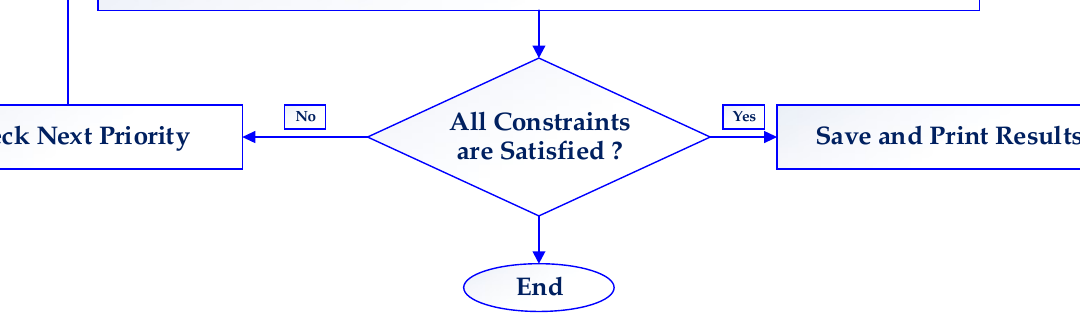
Figure 7. Flowchart of numerical methods for DN planning problems.